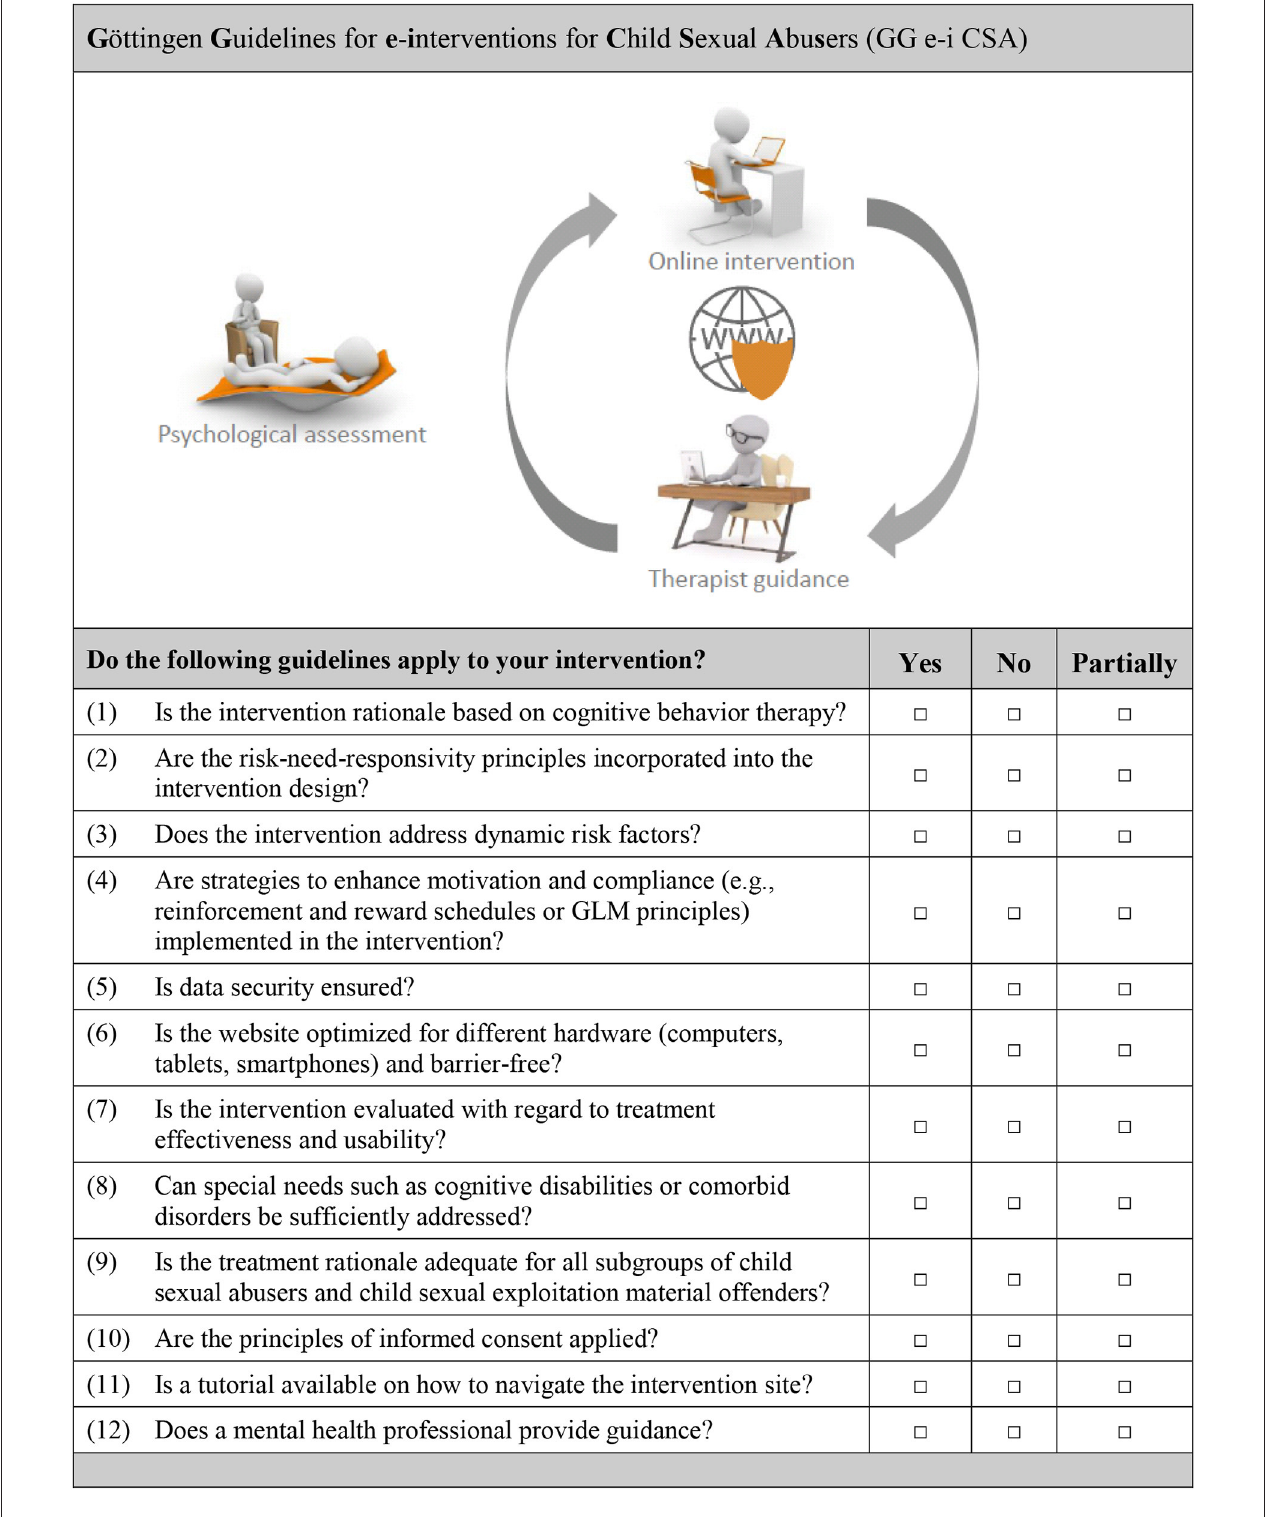
FIGURE 1 | Quality criteria checklist for the development and implementation of web-based interventions for child sexual abusers and child sexual exploitation material offenders.